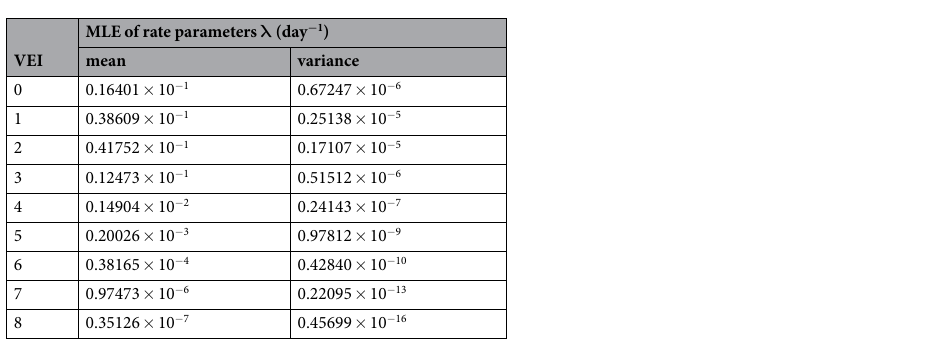
Table 2. Maximum likelihood estimates (MLE) of rate parameters for the exponential distributions of return times. The rate parameters λ refer to the distributions in Fig. 2 (non-normalized distributions are shown in Supplementary Fig. 1). The exponential distributions have mean return times β equal to 1/ λ , and variance β 2